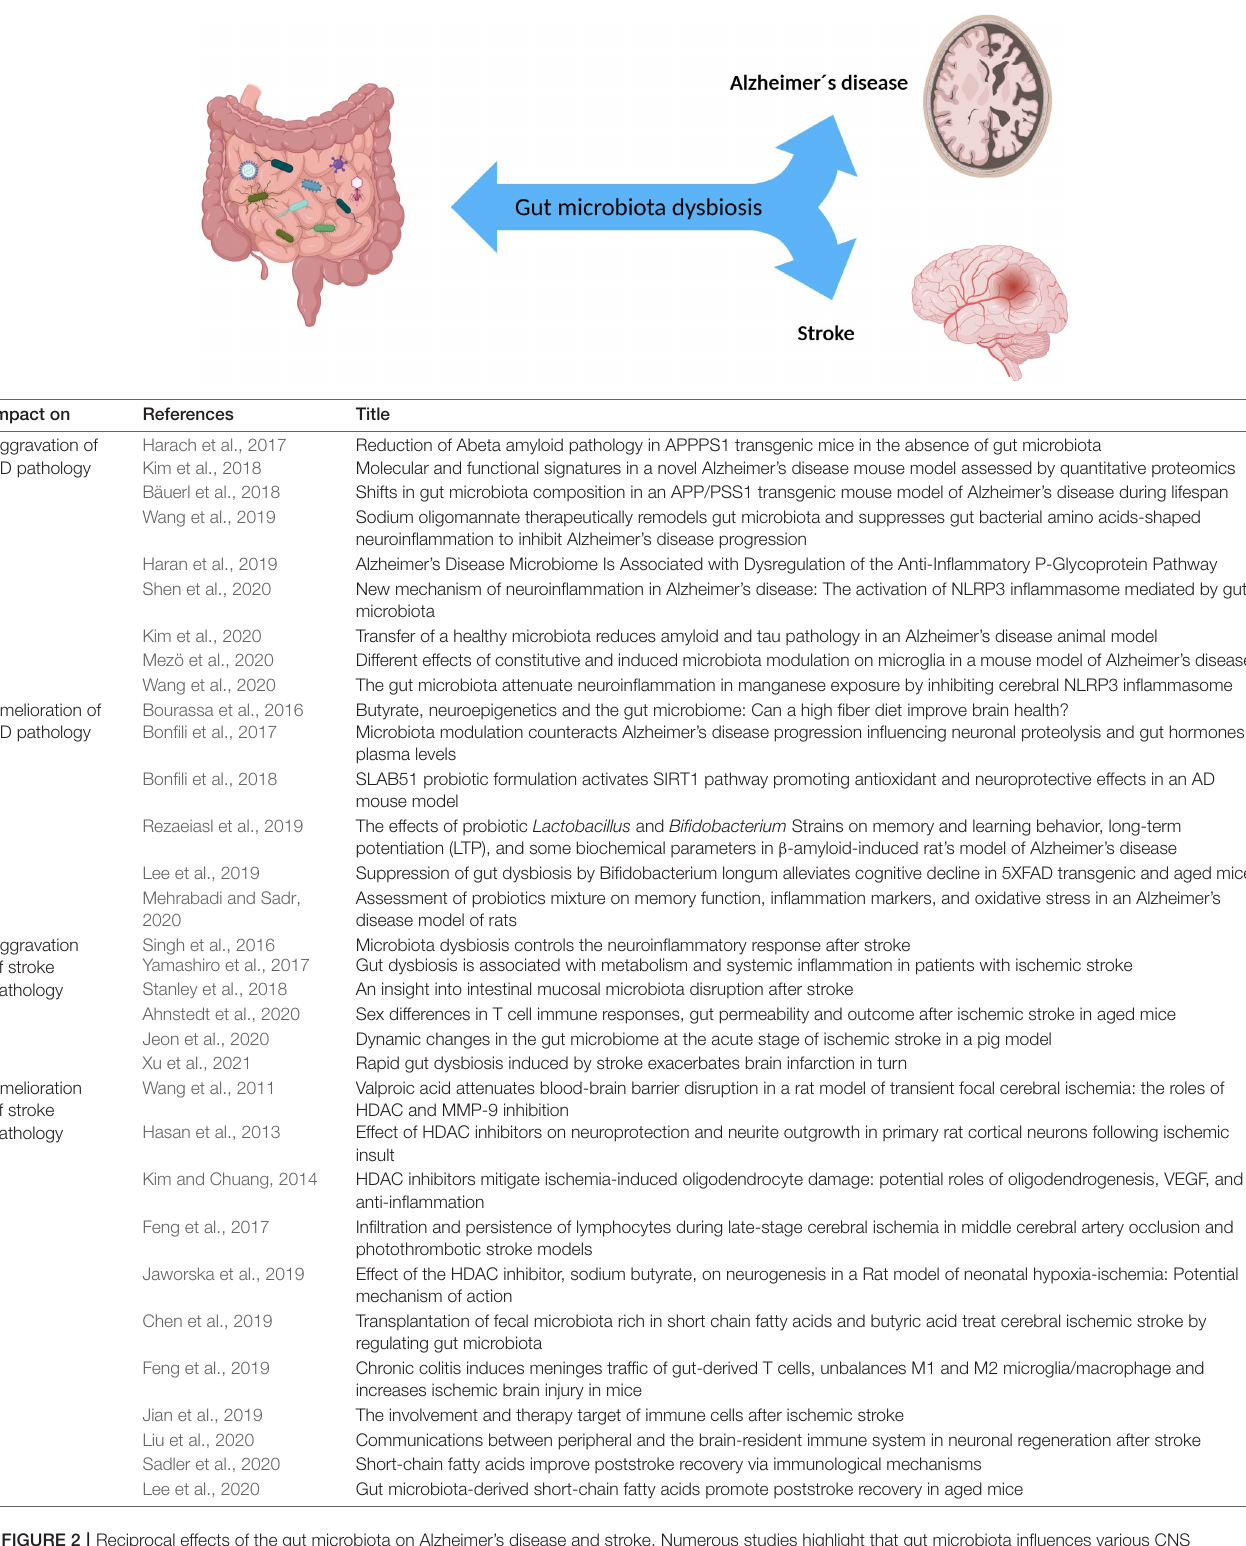
FIGURE 2 | Reciprocal effects of the gut microbiota on Alzheimer’s disease and stroke. Numerous studies highlight that gut microbiota influences various CNS disorders such as Alzheimer’s disease and stroke in a negative and/or positive fashion. CNS disorders can also act on gut microbiota composition via the gut-brain axis. Table lists corresponding references, all studies are primarily based on rodent data with the exception of reference (Yamashiro et al., 2017; Haran et al., 2019; and Jeon et al., 2020).